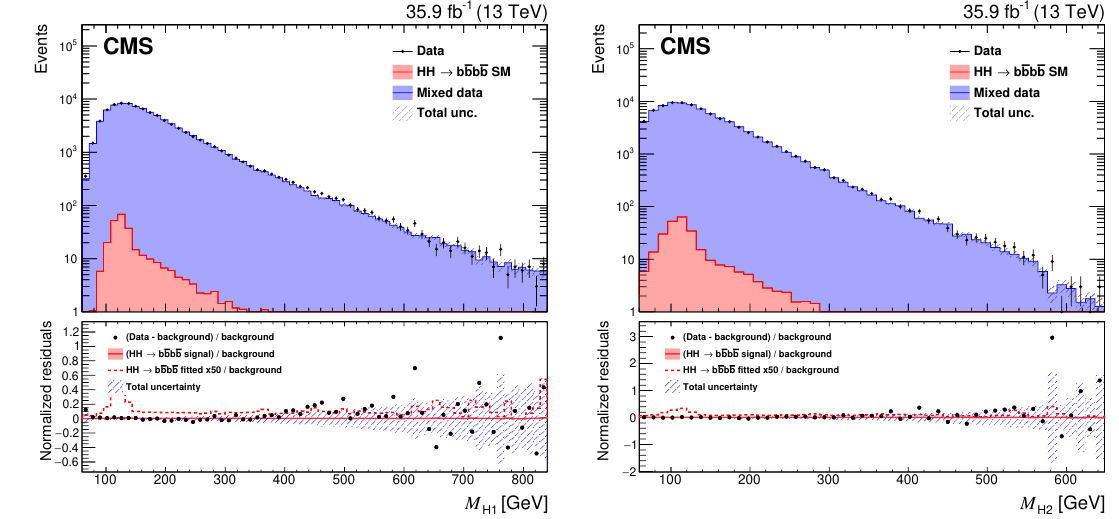
(left) and M H (right). Bias correction for the background 1 2